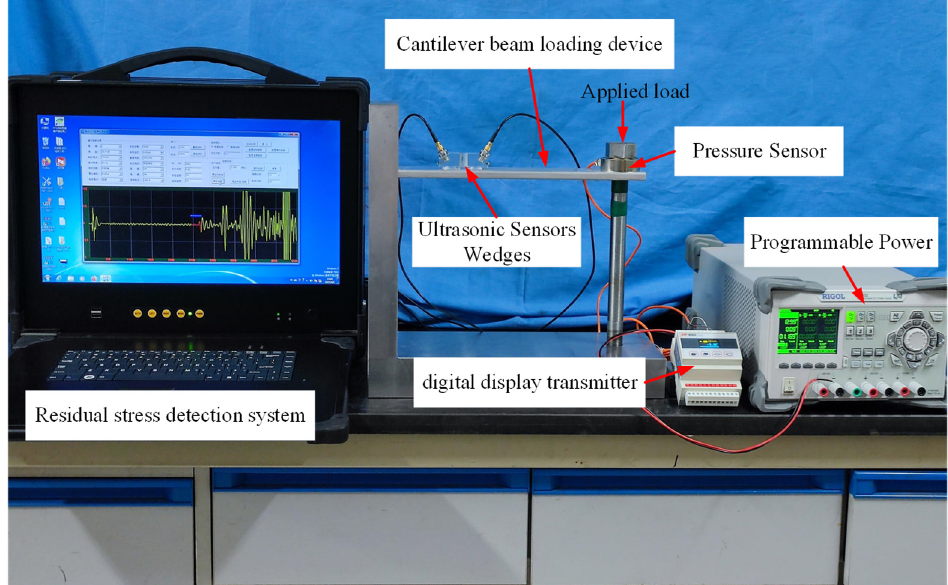
Figure 5. Schematic diagram of cantilever beam stress-loading and measurement.